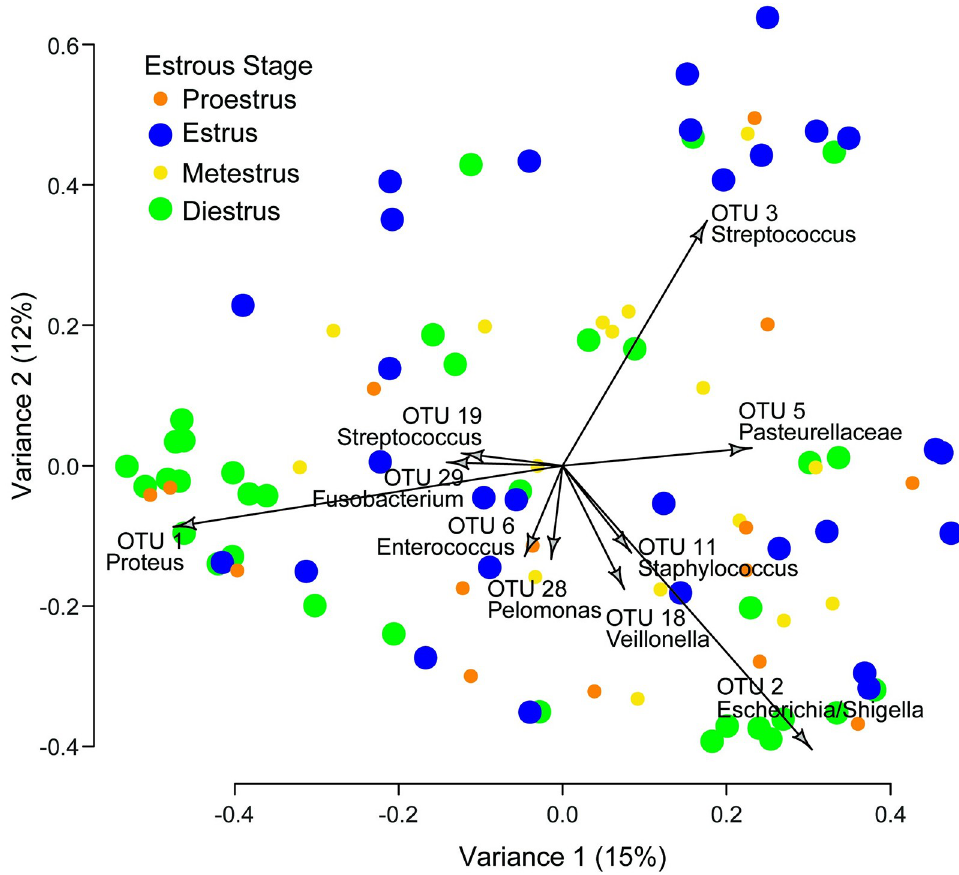
Fig 2. Principal Coordinate Analysis (PCoA) of all samples during baseline period. Two-dimensional distances identify dissimilarities between samples based on relative abundances of OTU. Biplot arrows indicate specific OTU which drive samples to different locations on the plot. The first PCoA axis (x-axis) included 15% of all variance. The second PCoA axis (y-axis) included 12% of all variance. Icons for estrus and diestrus are enlarged to help visualize the relative clustering of